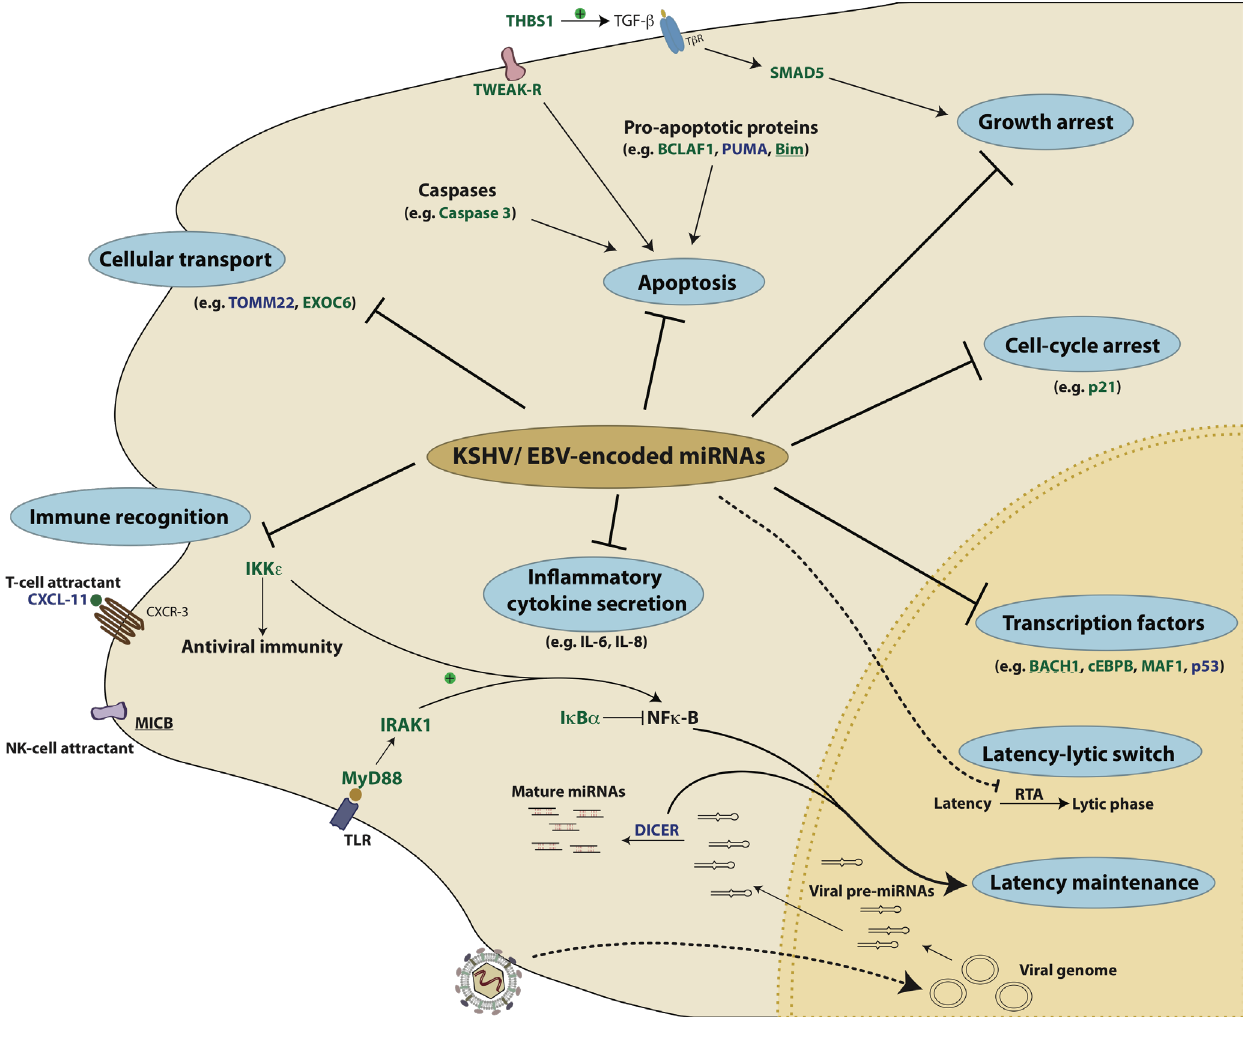
Figure 4. KSHV- and EBV-encoded miRNAs target several key pathways to establish disease. 1) Viral miRNAs can inhibit pro-apoptotic proteins like Bim and BCLAF1. 2) Viral miRNAs can also enable the infected cells to evade recognition by the immune system by repressing either the T-cell attracting chemokine, CXCL-11 or the NK-cell attracting ligand, MICB. 3) miRNAs can also inhibit the production of interferons and inflammatory cytokines by repressing factors like IKKε, IRAK1 and MyD88. 4) By repressing factors l ike IκBα and Dicer, viral miRNAs can also regulate latency. In addition to cellular targets, the RTA protein of KSHV that acts as the master regulator of the latency-lytic switch, is itself a target of KSHV miRNAs. 5) Several transcription factors like BAC H1, c/EBPβ and p53 are repressed by KSHV and EBV miRNAs. 6) KSHV miRNAs repress p21 and SMAD5 to overcome p21- and TGFβ - mediated growth arrest, respectively. In this illustration, the targets of KSHV miRNAs are in green, those of EBV miRNAs are in blue and targets that are repressed by both KSHV and EBV are underlined. The dotted line represents a viral target of KSHV-encoded